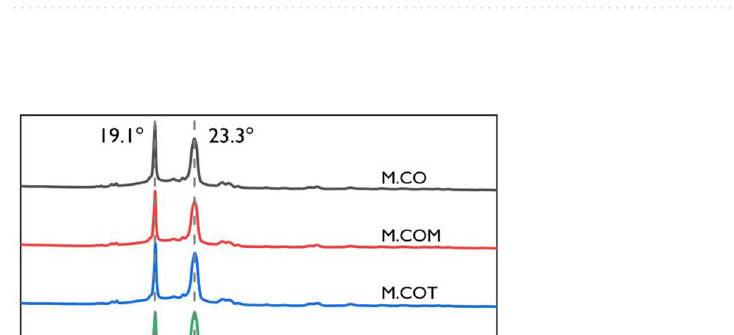
Figure 1. FT-IR spectra of the SSPCMs.